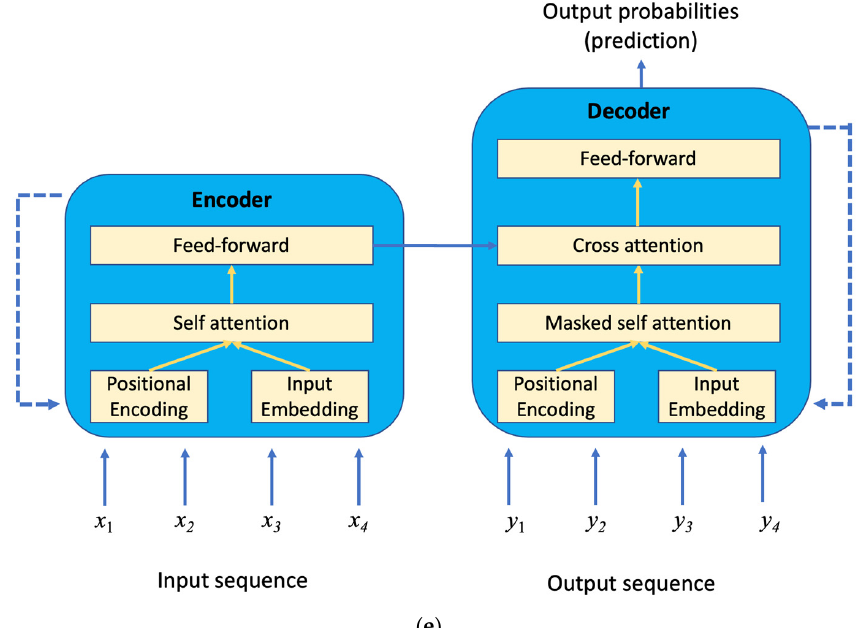
Figure 2. Popular deep learning models. ( a ) A feed-forward artificial neural network, with three fully connected layers: input layer with 7 nodes, hidden layer with 4 nodes, and output layer with 2 nodes, for binary classification. ( b ) A 2D CNN with 1 convolution layer, 1 max-pooling layer, 1 fully connected layer, and 1 output layer which has 128 output nodes capable of classifying images of 128 classes. The labels on top of each feature map, such as 8@64x64, refer to the number of convolution filters (8) and dimensions of feature map in x and y directions (64 on each side). ( c ) An example of RNN. x ( i ) means the i th input in the series of data. y ( i ) is the output. h ( i ) is a hidden state. W h and W x are the weights applied to input at x ( i ) and h ( i − 1 ) , respectively, to derive h ( i ) . W y is the weight applied to h ( i ) to derive y ( i ) . W h , W x , and W y are weights shared at all recurrent states. ( d ) An example of LSTM with a forget gate. C ( t ) refers to the cell state vector, which keeps long-term memory. h ( t ) ∈ ( − 1,1 ) h is the hidden state vector. It is also known as the output feature when the model finishes training. X is the input feature vector and each element X ( t ) is the input (new information) at time t . tanh refers to the hyperbolic tangent function. ( e ) A transformer model architecture for sequence-to-sequence